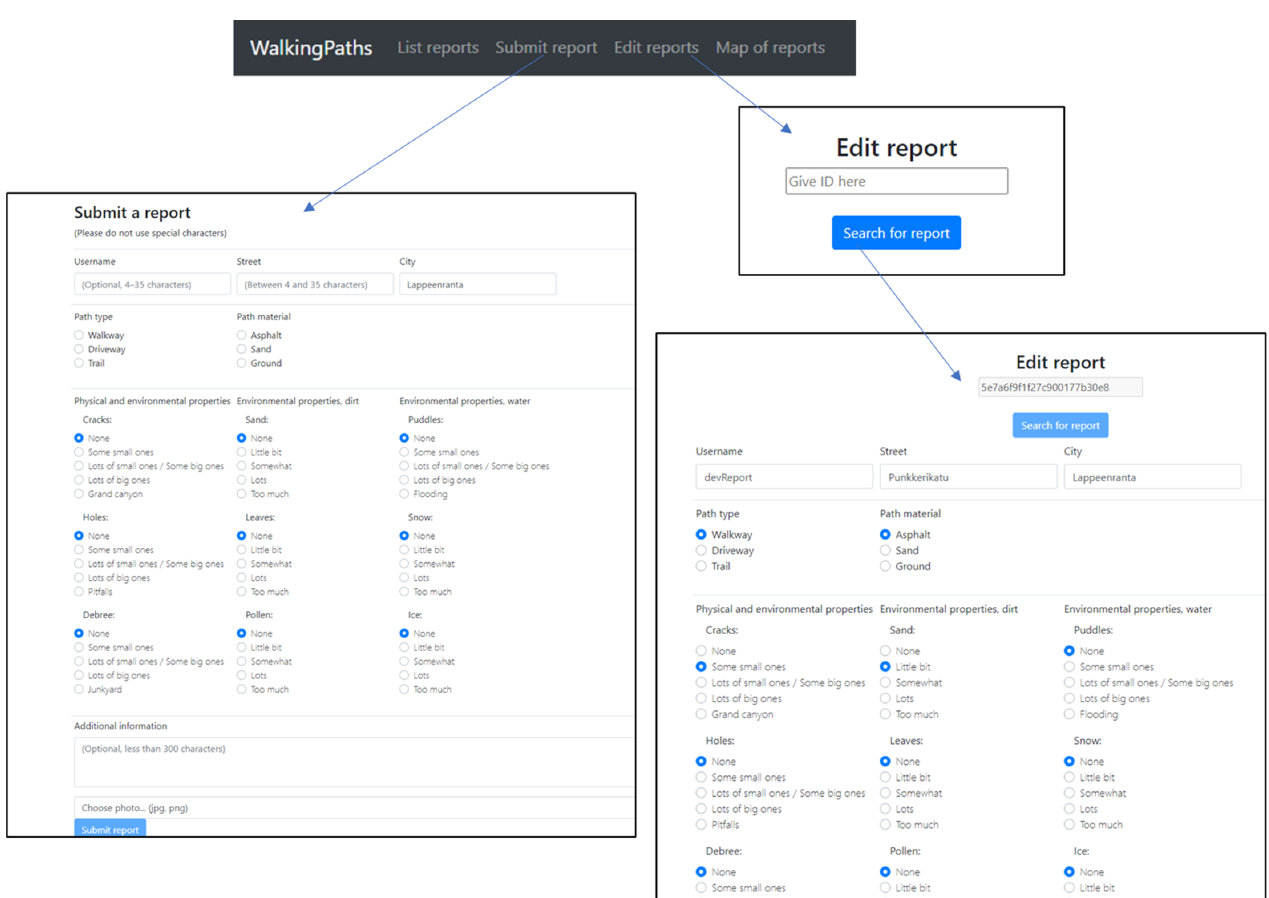
Figure 4. The New observation and Edit observation views of WalkingPaths.